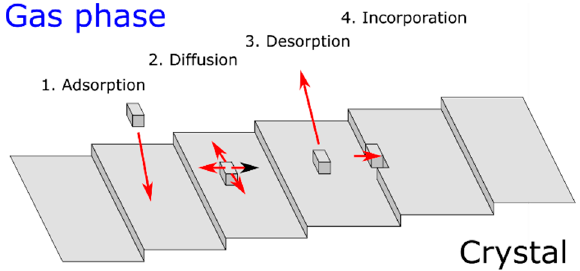
Figure 10. Different processes taken into account in the BCF model of crystal growth on vicinal surfaces.